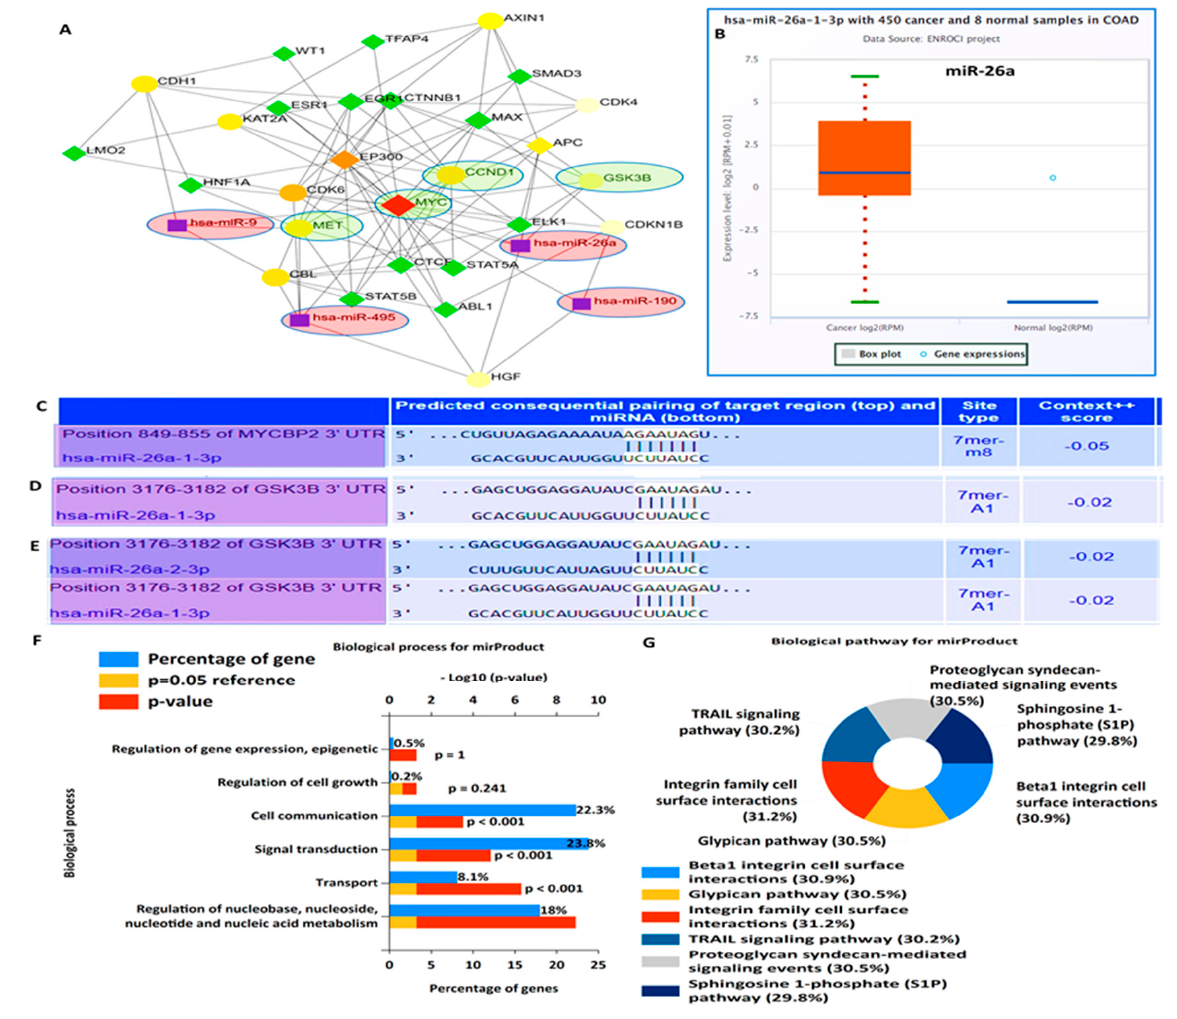
Figure 4. Network topology profiling of miRNAs that targets c-Met, GSK3 β , MYC, and CCND1 oncogenes specifically, with * p < 0.05 considered statistically significant.